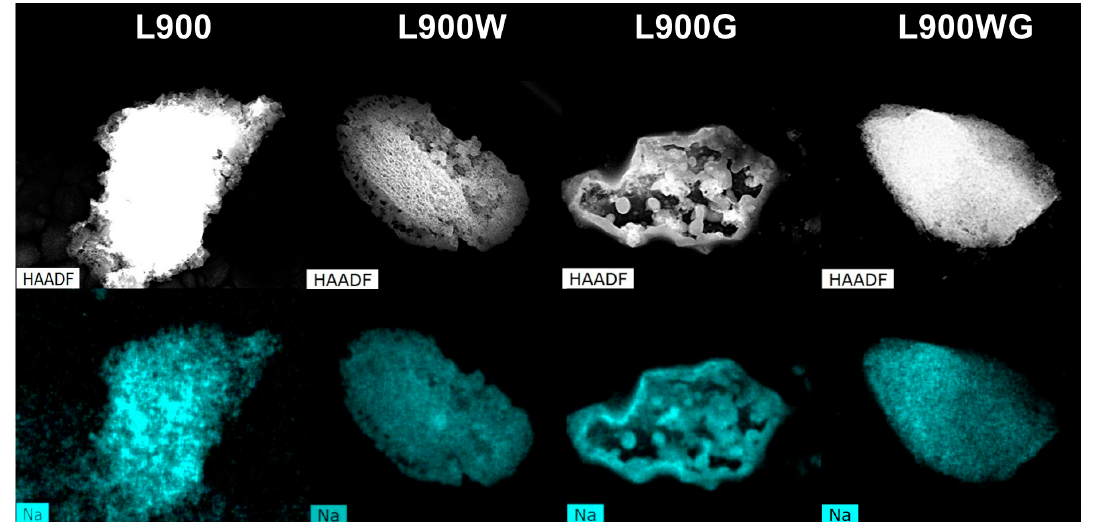
Figure 4. Sodium dispersion mapping from SEM equipped with energy ‐ dispersive X ‐ ray analyses (SEM ‐ EDX) of the different carbon catalysts.